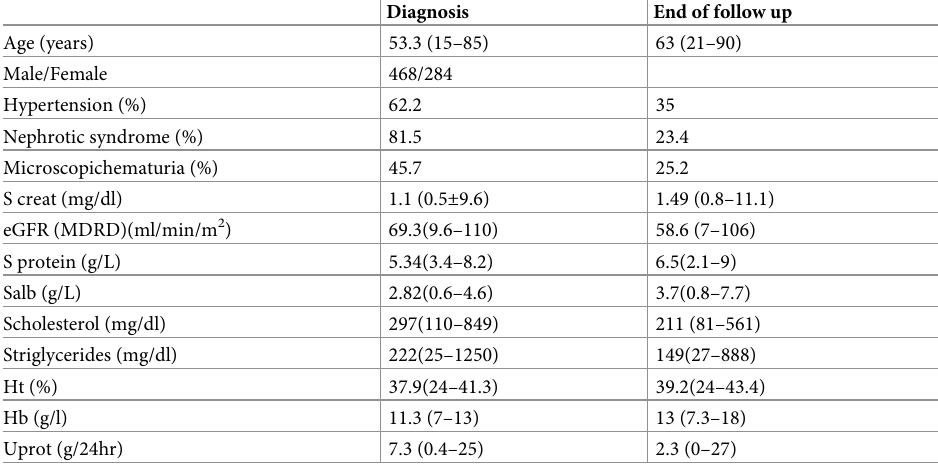
Table 1. Clinical and laboratory findings of the 752 patients with primary MN at time of diagnosis and at the end of follow up [121.8 (14–372)months].